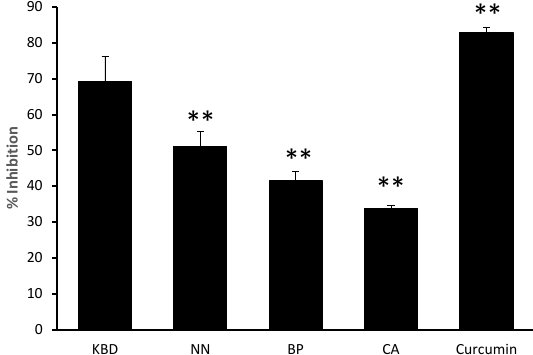
Figure 2. The effect of the KBD and its components on AChE activity. The KBD extract 3 mg/mL (KBD) and its components at equivalent amount, i.e., Nelumbo nucifera 1 mg/mL , (NN), Piper nigrum 1 mg/mL (BP), and Centella asiatica 1 mg/mL (CA) were evaluated for AChE inhibitory action by Ellman’s assay. Data are reported as means ± SD ( n = 3). ** p < 0.01 as compared with the KBD group. Tacrine 0.30 µM was used as a positive control.